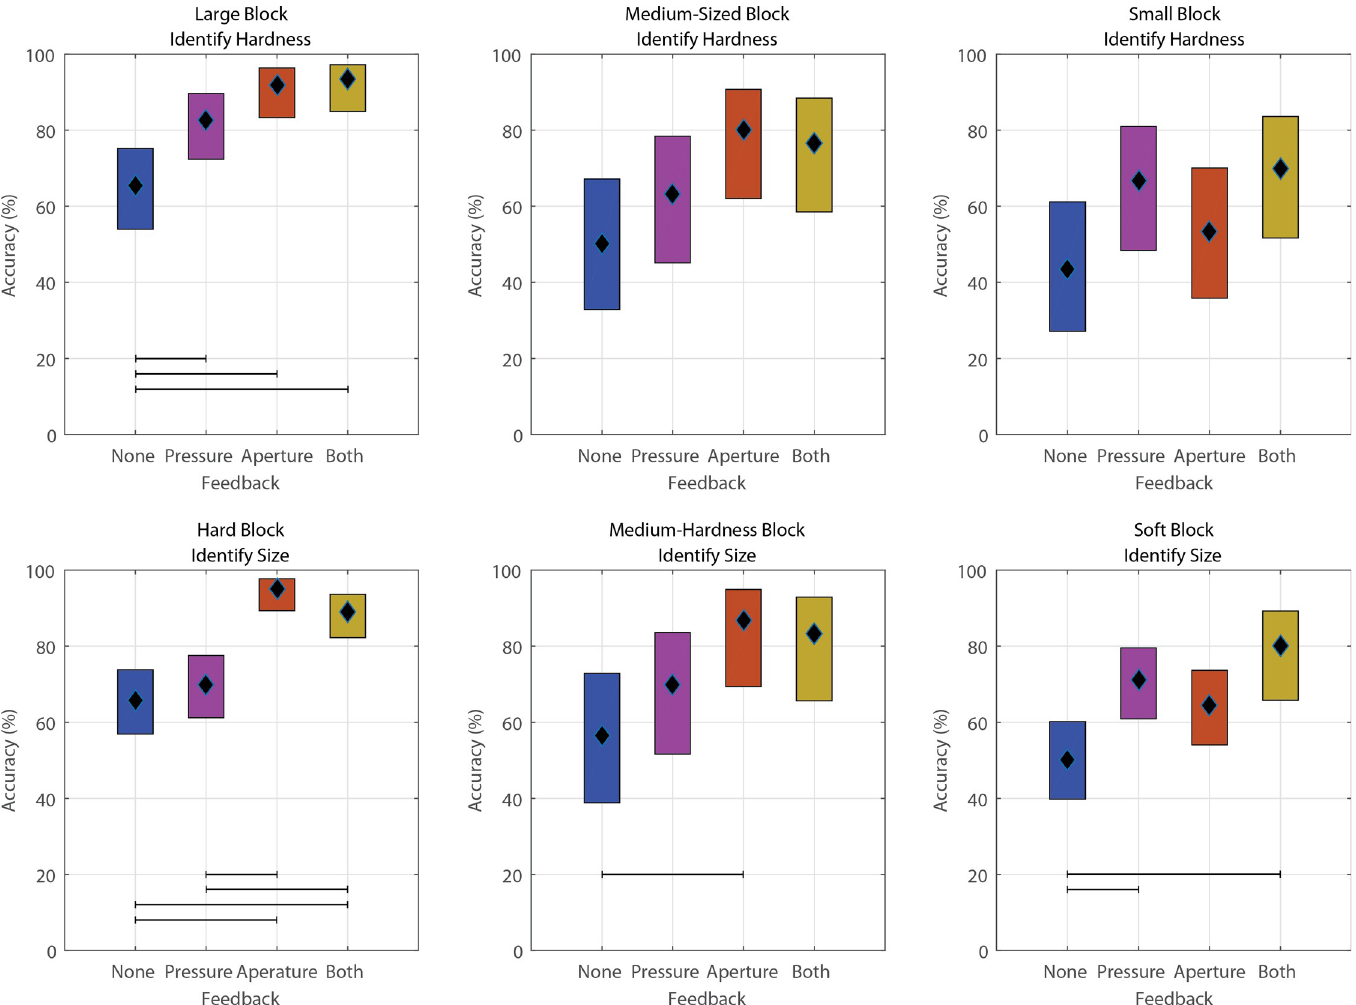
Fig 4. 95% confidence interval of the accuracy of block identification for S2. Black diamond denotes the mean. Observations that are significantly different (ANOVA with multiple comparison correction; p < 0.05) are distinguished with horizontal bars. In general, S2 performed best when sensory feedback was provided, but the best form of feedback depended on the block identification task. Averaged across all blocks in a particular identification task. Number of observations included in each panel are: top row (left-to-right): 300, 120, 120; bottom row (left-to-right): 480, 120,